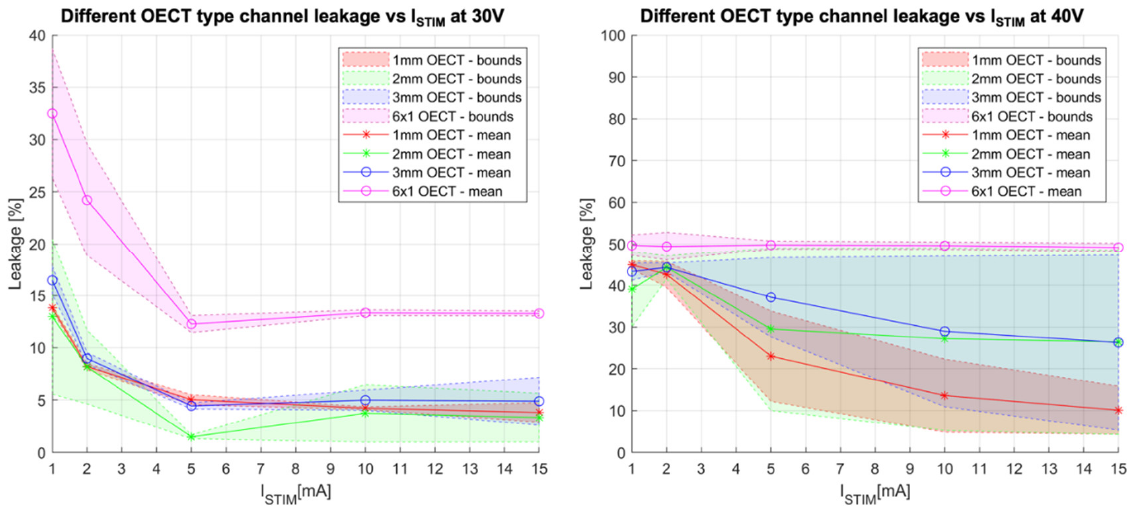
Figure 8. Estimated leakage current in the closed branch for various current levels at an output voltage of 30 V ( left panel ) and 40 V ( right panel ), respectively. The bounds of the expected current leakage were estimated based on measurements in both states of the parallel branches, where exactly one branch was conductive at each instant.